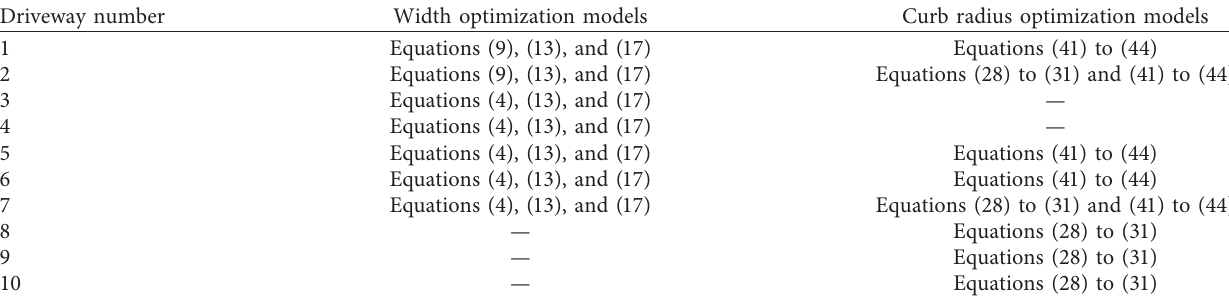
Table 7: Relationship between driveways and design models.